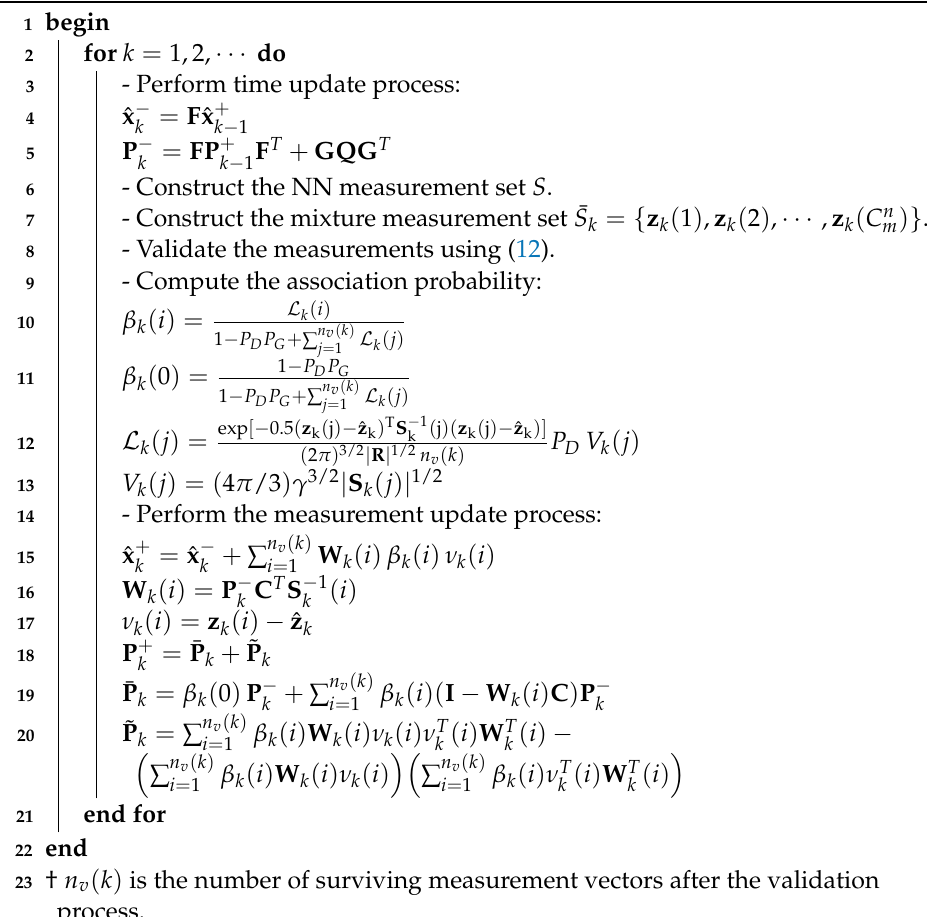
Algorithm 2: PDAF-based localization the true/false mixture